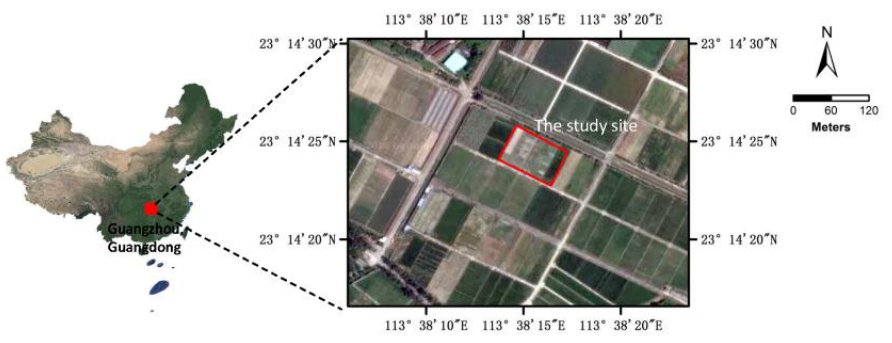
Figure 1. The general location of the study site.